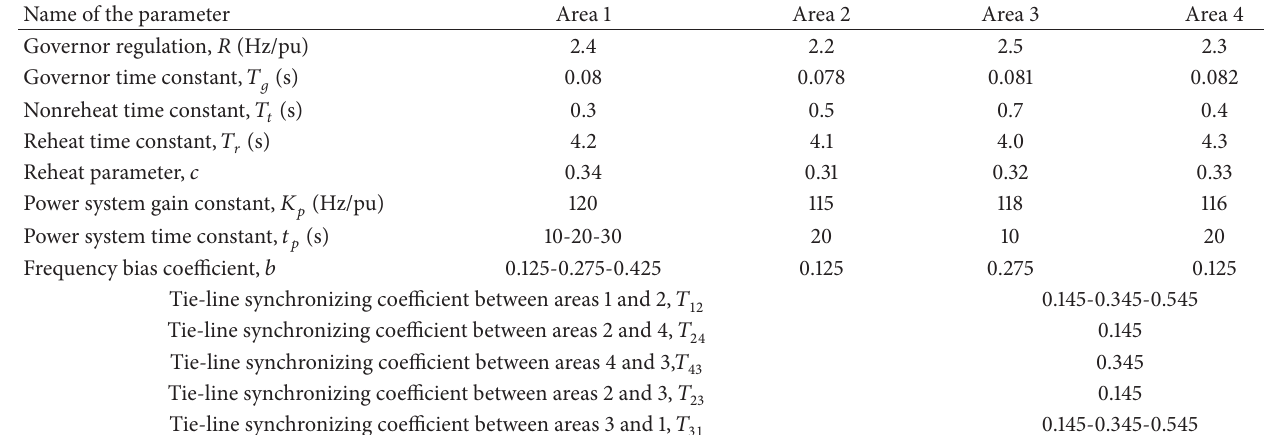
Table 7: Four area